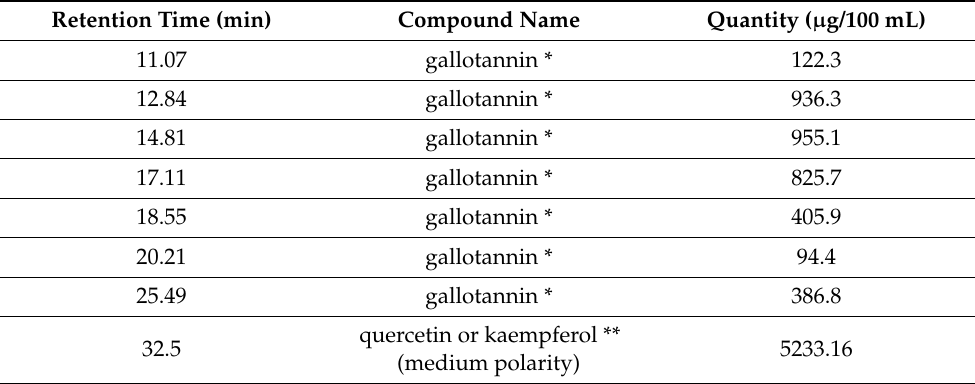
Table 2. Punica granatum L. glycolic extract characterization.